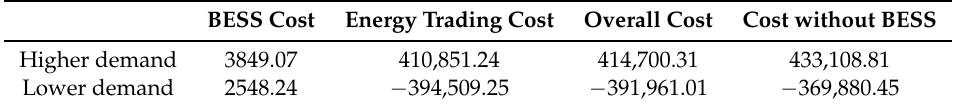
Table 3. Costs solved with both data